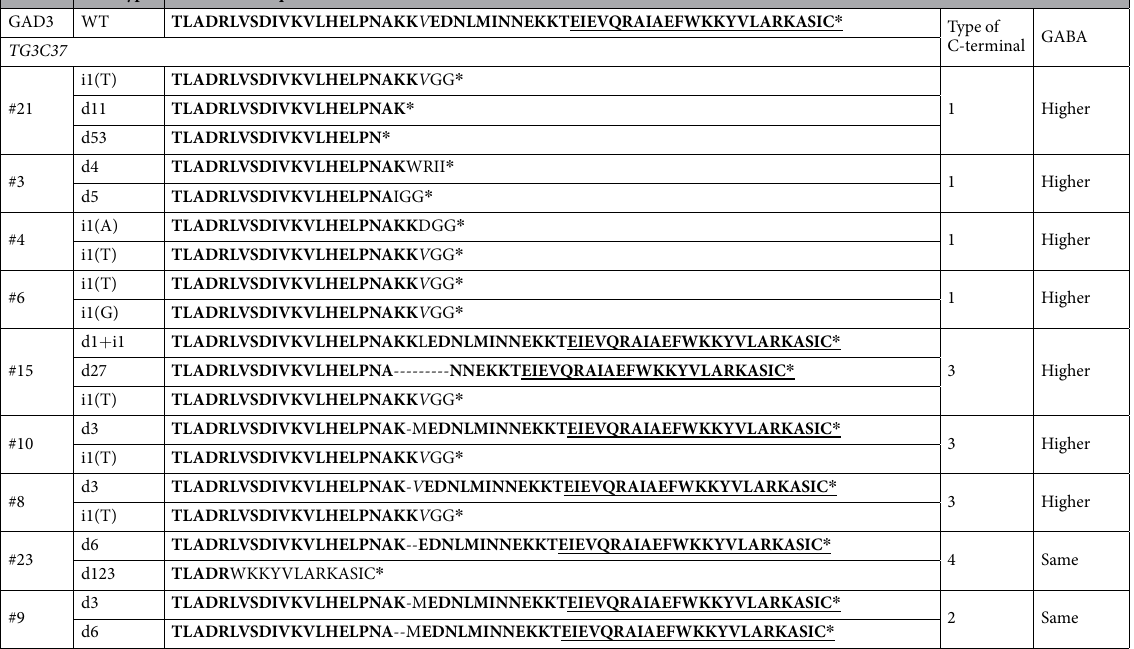
Table 2. Amino acid sequence of Target site (T0 generation). WT, wild-type sequence with no mutation detected. “d” and “i” means deletion and insertion, respectively. “ * ” was stop codon. The same sequence as Wild Type is expressed in Bold . The changed sequence by the mutation via CRISPR/Cas9 was in Regular. Bold with underline is the putative auto inhibitory domain and CaMd domain. The target site is in Italic . “a” and “b” in Superscript mean different one base-pair deletion. “Higher” showed higher GABA content comparing with WT. “Same level” indicated almost the same contain level as WT. n.d. means no data. GABA content was measured using fruits at the Br + 10 stage